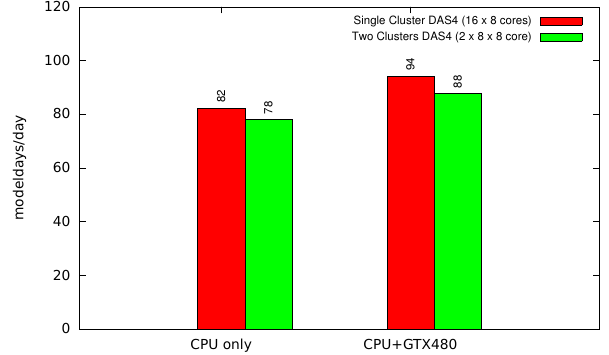
obtained on the Tesla K20 GPU with a 229 × 304 block size.